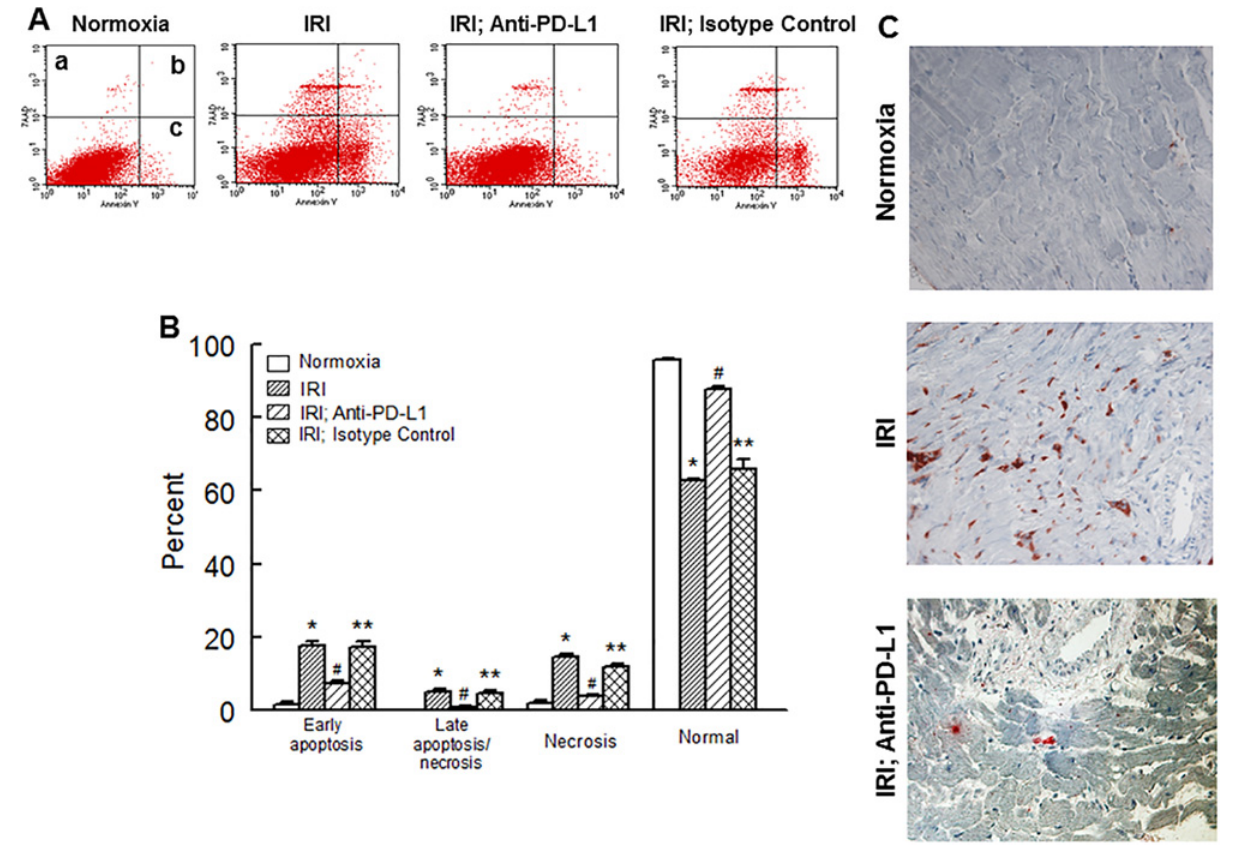
Fig 6. Representative dot matrices for apoptotic and necrotic cell death of experimental groups are shown under panel A while bar graphs (panel B) show percent of each type of damaged/dead or normal cells for each group. Data are means ± SEM; n = 6 hearts/group for normoxic control, IRI and IRI; Anti- PD-L1 and n = 4 hearts for IRI; isotype matching control. Also shown are representative caspase 3 immunostaining for experimental groups (panel C). 400x. 7AAD: 7-Amino Actinomycin D. a: necrotic; b: apoptotic/necrotic; c: early apoptotic. IRI: Ischemia Reperfusion Injury. * p < 0.05 compared to the normoxic group. ** p < 0.05 compared to normoxia or IRI; Anti-PD-L1 group. # p < 0.05 compared to IRI or IRI; Isotype control group.